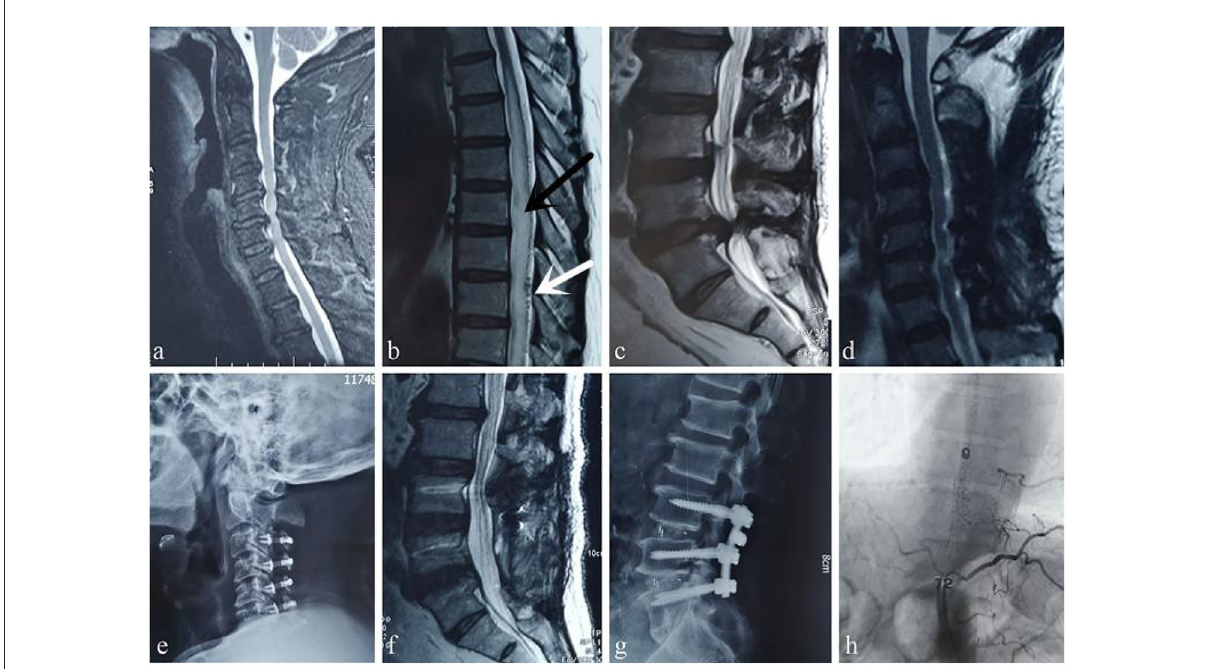
FIGURE3 Case 3. A 59-year-old man was first evaluated at the orthopedic clinic because of “progressive lower extremity weakness and difficulty urinating for 2 month.” Cervical spine MRI shows spinal stenosis (a) , edema and signs of flow voids in the thoracic spinal cord, which are typical manifestations of a DVF (b) (white arrow: “beaded” dilated flow void signals, black arrow: spinal cord edema), and lumbar spinal canal stenosis (c) . However, the orthopedic surgeon ignored the diagnosis of a DVF; he first performed cervical spinal canal expansion and decompression (d,e) and then misdiagnosed the disease as cauda equina syndrome caused by lumbar spinal stenosis and performed lumbar spinal canal decompression (f,g) . These interventions aggravated the disease. The patient presented at our hospital approximately 9 months after the surgeries. After MDT consultation, angiography performed by a neurosurgeon confirmed that the fistula was at the T9 level (h) .